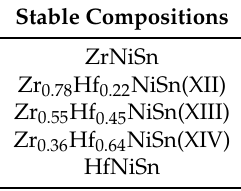
Table 2. Compositions of the stable Heusler phases with an error range of